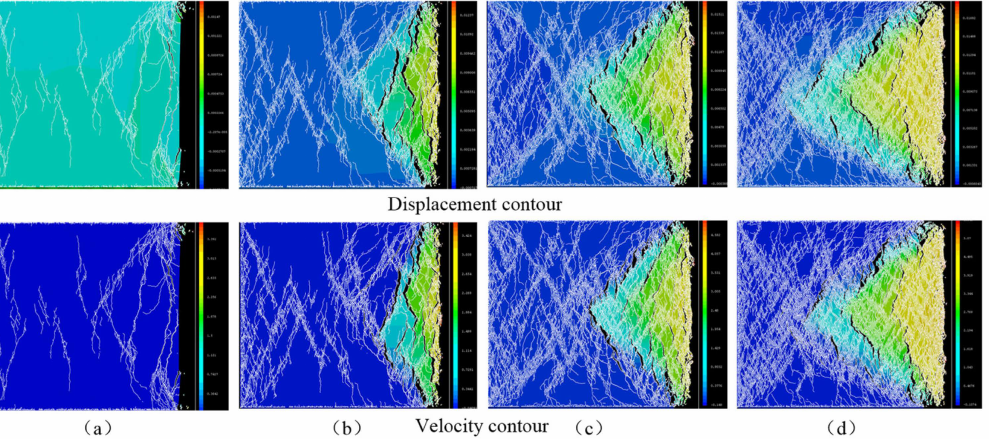
Figure 3. The crack distribution, displacement contour and velocity contour of numerical samples under different in situ stresses: ( a ) vertical stresses 5 MPa; ( b ) vertical stresses 7.5 MPa; ( c ) vertical stresses 10 MPa; and ( d ) vertical stresses 12.5